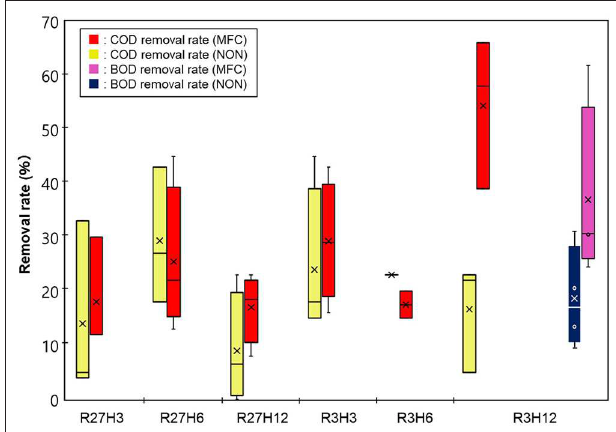
FIGURE 4 | The removal of organic matter by the MFCs operated under six different conditions.